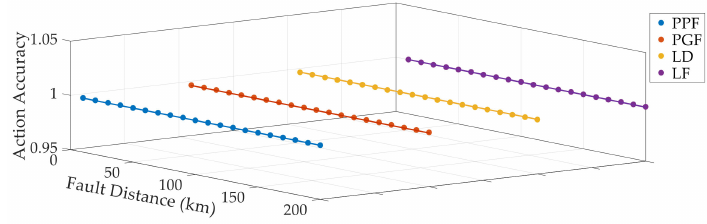
Figure 18. The influence of fault distance on the action